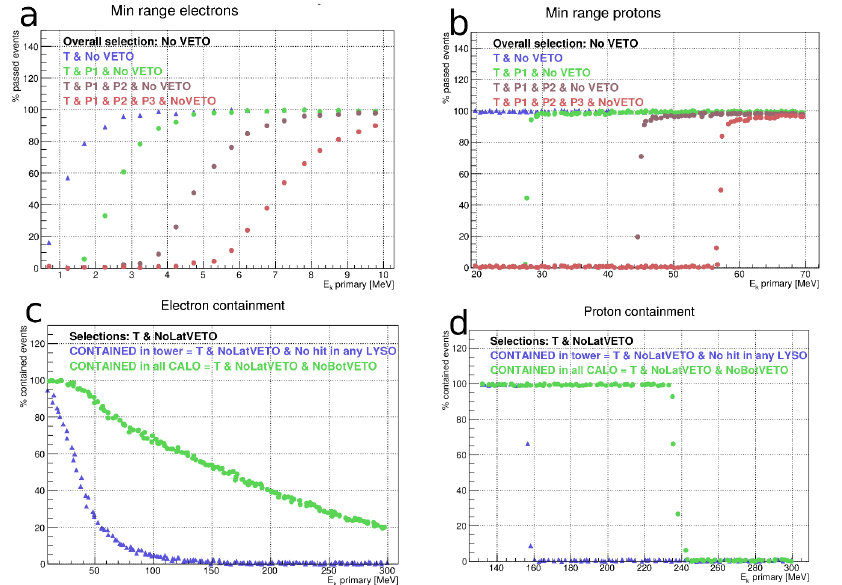
Figure 2. Left: Fraction of electrons (a) and of protons (b) that pass some trigger conditions as a function of primary energy; Right: fraction of electrons (c) and of protons (d) contained in the tower and in the whole calorimeter as a function of primary